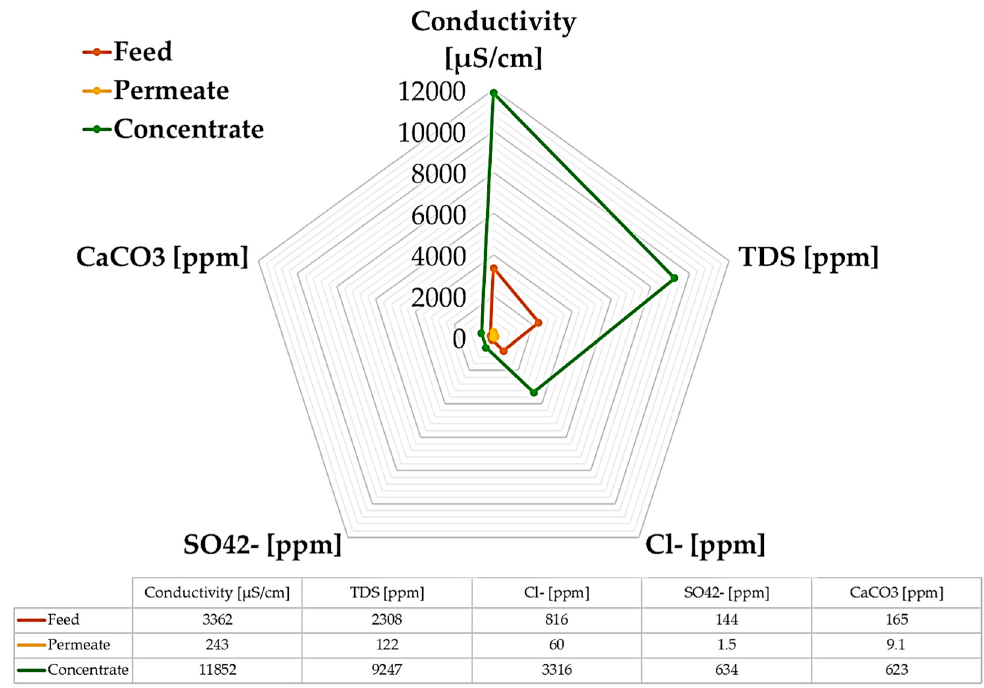
Figure 2. Test results in the case of no-retentate recirculation trials. Table 3. Comparison between removal efficiency of the first and the second period trials.